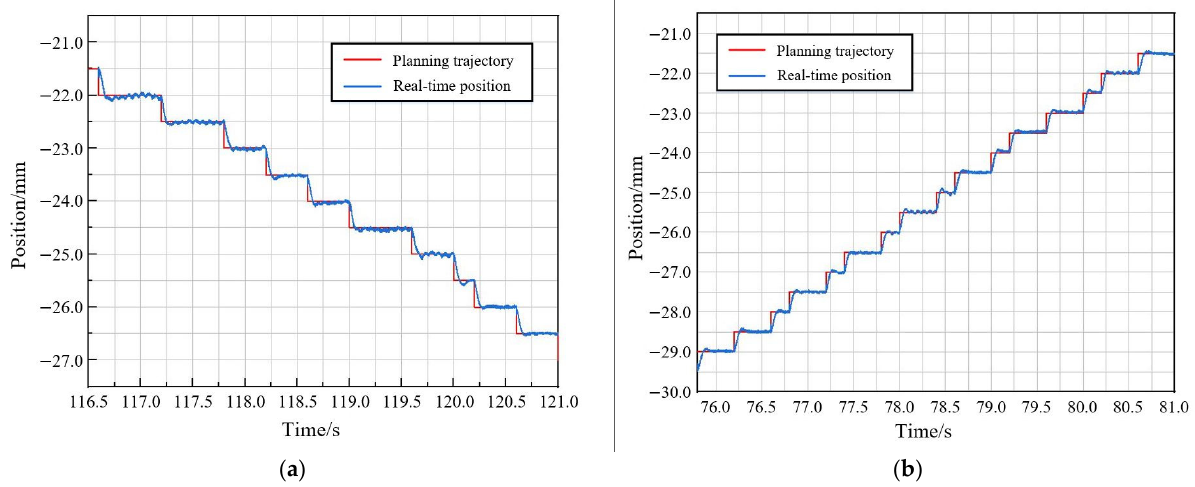
Figure 15. Levitation motion trajectory of the permanent magnet ball by step-by-step actuation control. ( a ) Descending motion; ( b ) Ascending motion.